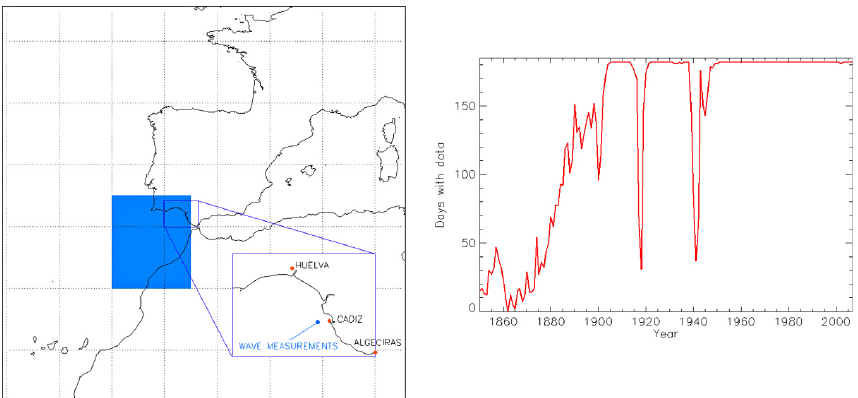
Fig. 2. Area selected to compute wind averages from the ICOADS database and some significant locations (left); number of winter (October– March) days with ICOADS wind observations inside the selected square (right).